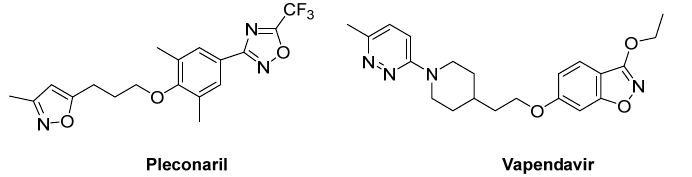
Figure 2. Chemical structures of the two capsid inhibitors pleconaril and vapendavir. Bernard et al. studied CV ‐ B3 and echovirus inhibitors and found that compound 6501 (Figure 3) was active with an EC 50 of 11 μ M [14].